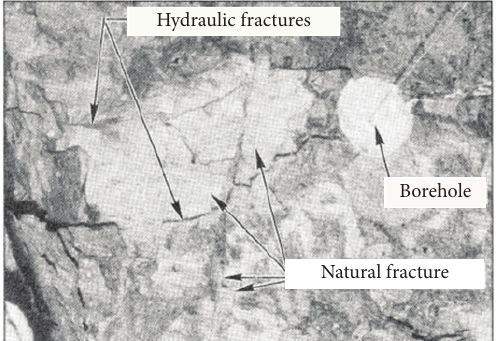
Figure 5: Complex fracture extension in fractured reservoir [4].